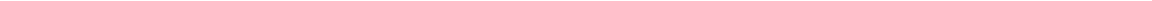
Fig. 7. The pholadomyoid bivalve Aksumya krystyni gen. et sp. nov. from the late Carnian, Late Triassic, Leo’s Terziler seep deposit in southern Turkey. A . Mo184066, paratype, internal mold of an articulated specimen with interior radial striations, right (A 1 ) and left (A 2 ) valves, note healed predation scars (arrows), dorsal view (A 3 ). B . Mo184067, holotype, specimen with preserved external surface, showing the overall outline of the shell; right (B 1 ) and left (B 2 ) valves, dorsal view (B 3 ). C . Mo184068, paratype, right valve with particularly strong ridge running from the middle of the dorsal margin to the anteroventral corner of the posterior adductor muscle scar. D . Mo184069, paratype, right valve of a large specimen showing the projection on the anterodorsal side of the anterior adductor muscle scar. E . Mo184070, paratype, left valve, and predation marks on the posteroventral side. F . Mo184071, paratype, internal mold of articulated specimen, right (F 1 ) and left (F 2 ) valves, dorsal view (F